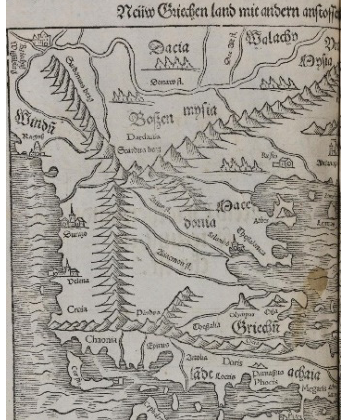
Figure 13. A map showing Macedonia the Cosmographia by S. Münster.